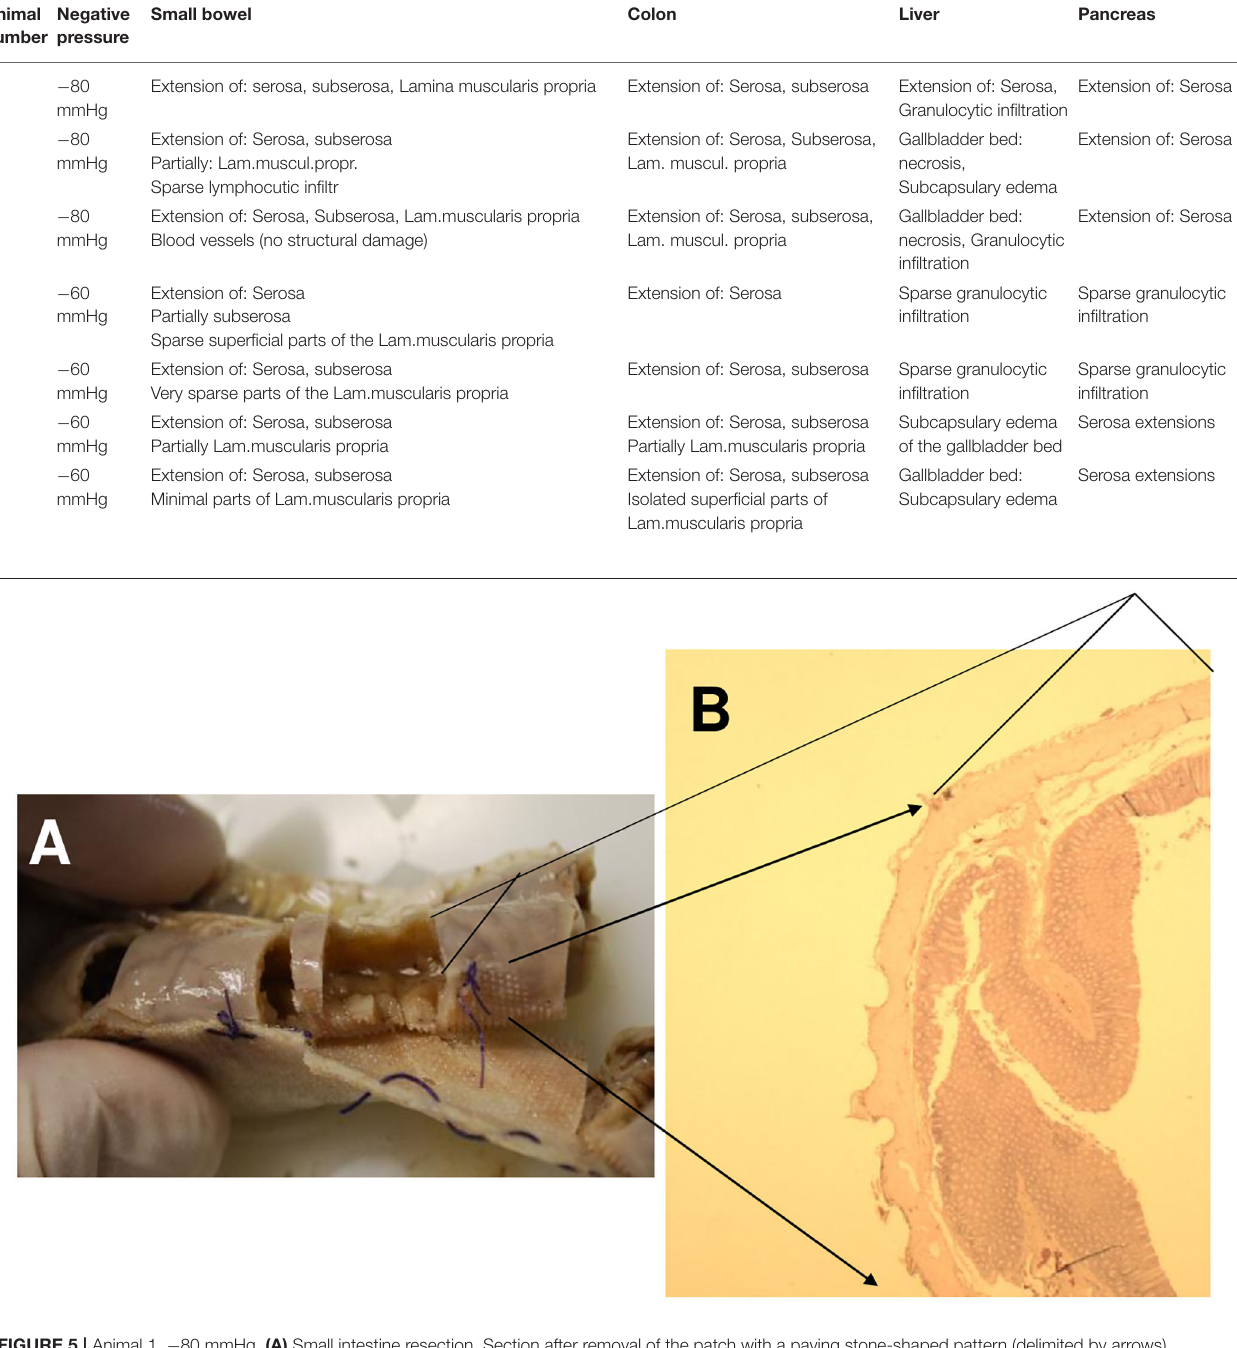
sign of damage or traces of discolored fluids, and no signs of fistula formation on the whole bowel surfaces. The mean amount of fluids collected was 507 ml (500–800), and all fluids were clear.